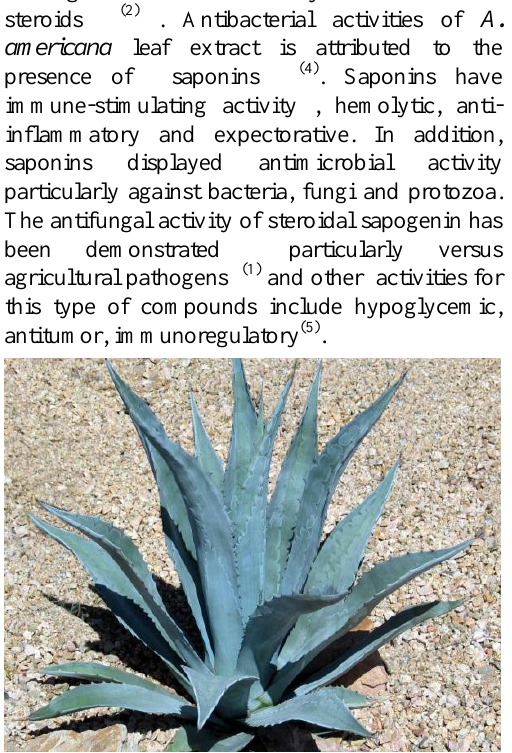
Figure (1): Agave americana plant cultivated in